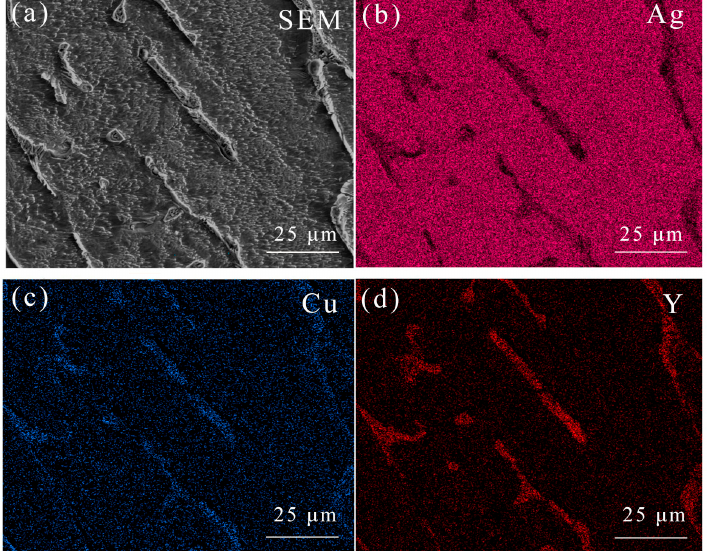
Figure 5. EDS surface scanning of the morphology ( a ), the distribution of Ag ( b ), Cu ( c ), and Y ( d ) in the Ag–1.5Cu–1.0Y alloys under the rotation speed of 900 r/min.